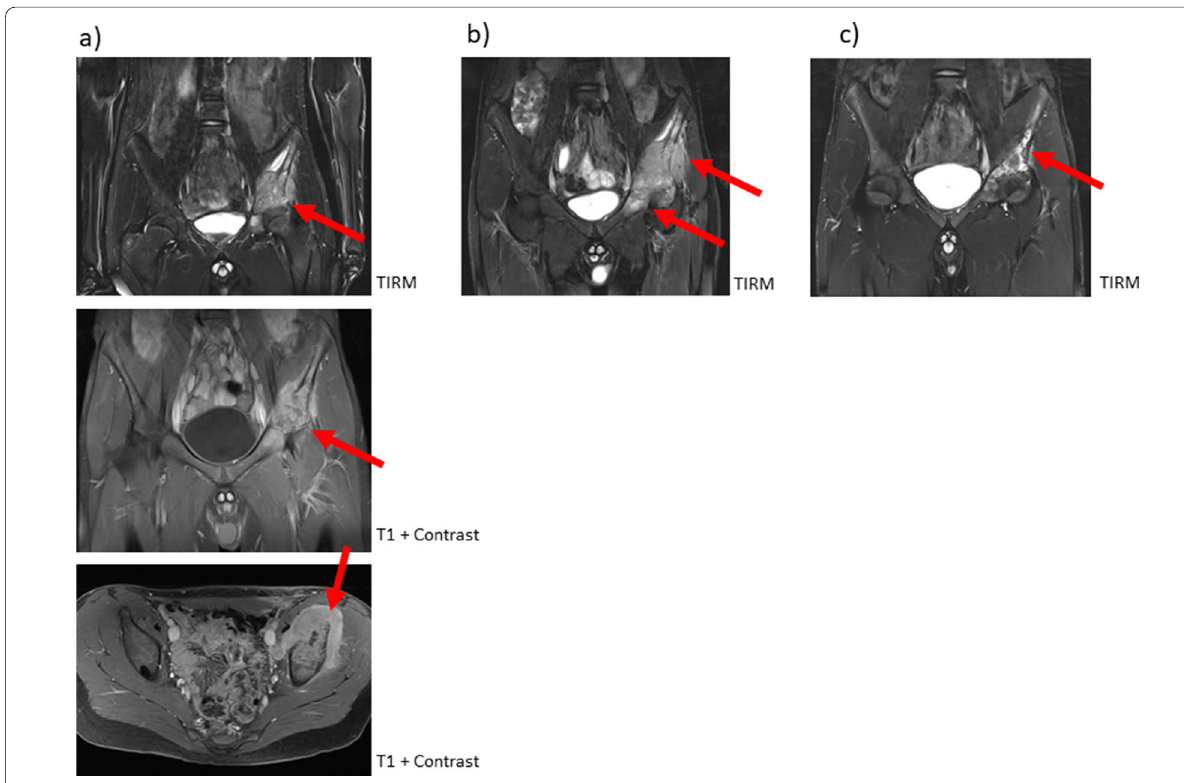
Fig. 4 A 14-year-old boy with pain in the left groin and feet. MRI showed an extended focus in the left os ileum/acetabulum with marked paraosseous soft tissue involvement. After bone biopsy of the left os ileum with negative cultures and no evidence of malignancy, therapy was initiated with naproxen, steroids and methotrexate. Three months after the initial MRI, the boy had increasing pain. A follow-up study showed progressive soft tissue swelling with destruction of the left acetabulum/os ileum. After repeat bone biopsy further methotrexate plus pamidronate treatment. A second follow-up MRI showed decreased soft tissue swelling with slightly persisting signal abnormality within the